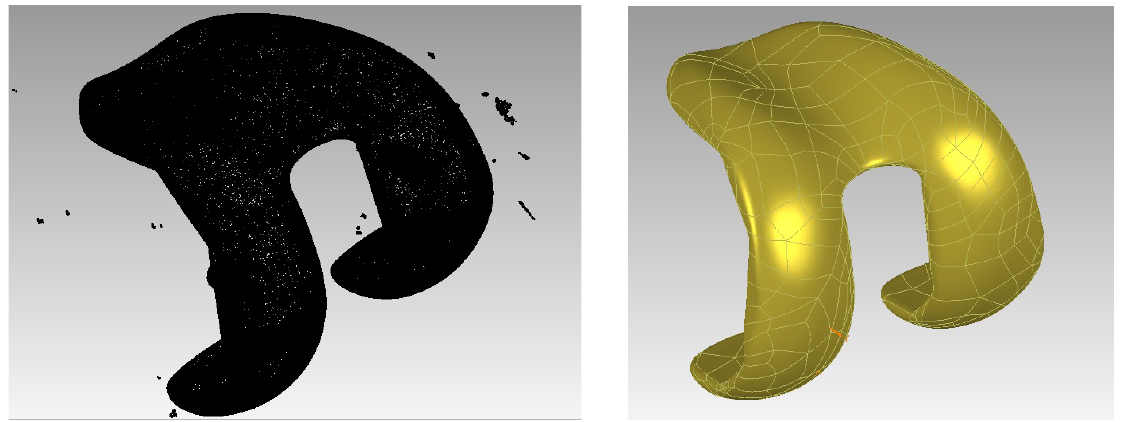
Figura 4: Componente femorale: a sinistra la nuvola di punti acquisiti, a destra il modello NURBS. Figure 4: Femoral component: the point cloud acquired (left) and the NURBS model